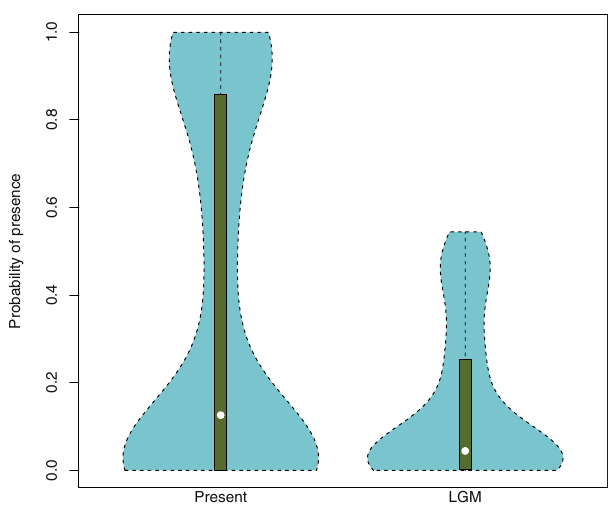
uncertainty could affect our hindcast results only in the Mediterranean coasts of France and in the North of the Adriatic Sea, the coldest regions in the Mediterranean Sea during the LGM. Comparison of range predictions with genetic diversity and structure of P. oceanica popu- lations. When examining predictions by distinct genetic regions, the Central (both C. I and C. II regions) showed higher probability of presence during the LGM than those for the Western and Eastern Mediterranean (Fig. 4). This is in agreement with the higher allelic richness (A) found by both studies in these Central regions, in comparison with the other regions (mean A = 42.37 in C. I; 49.66 in Central; 48.5 in C. II; see also Fig. 4).